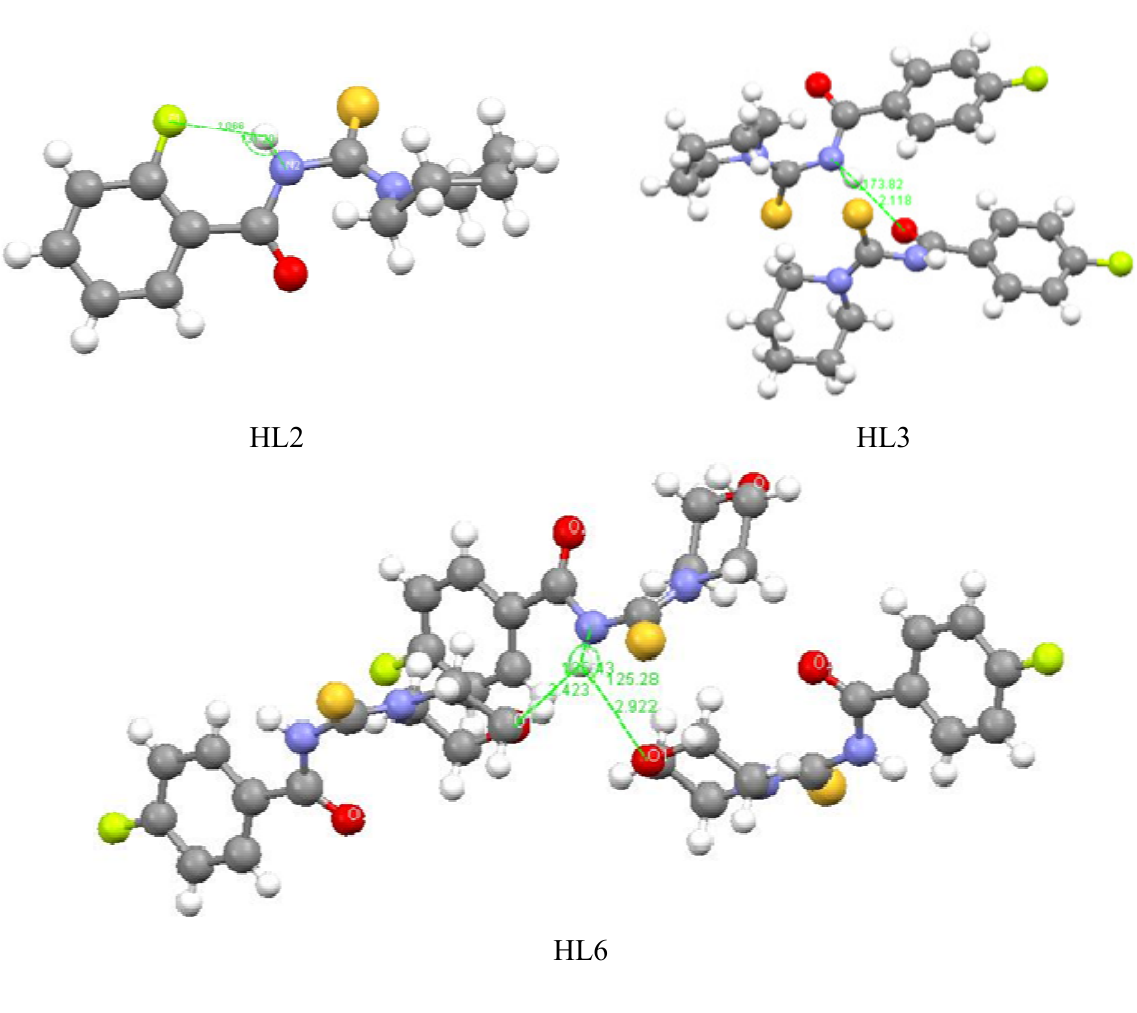
Figure 4. The packing diagrams of the corresponding hydrogen bonds of